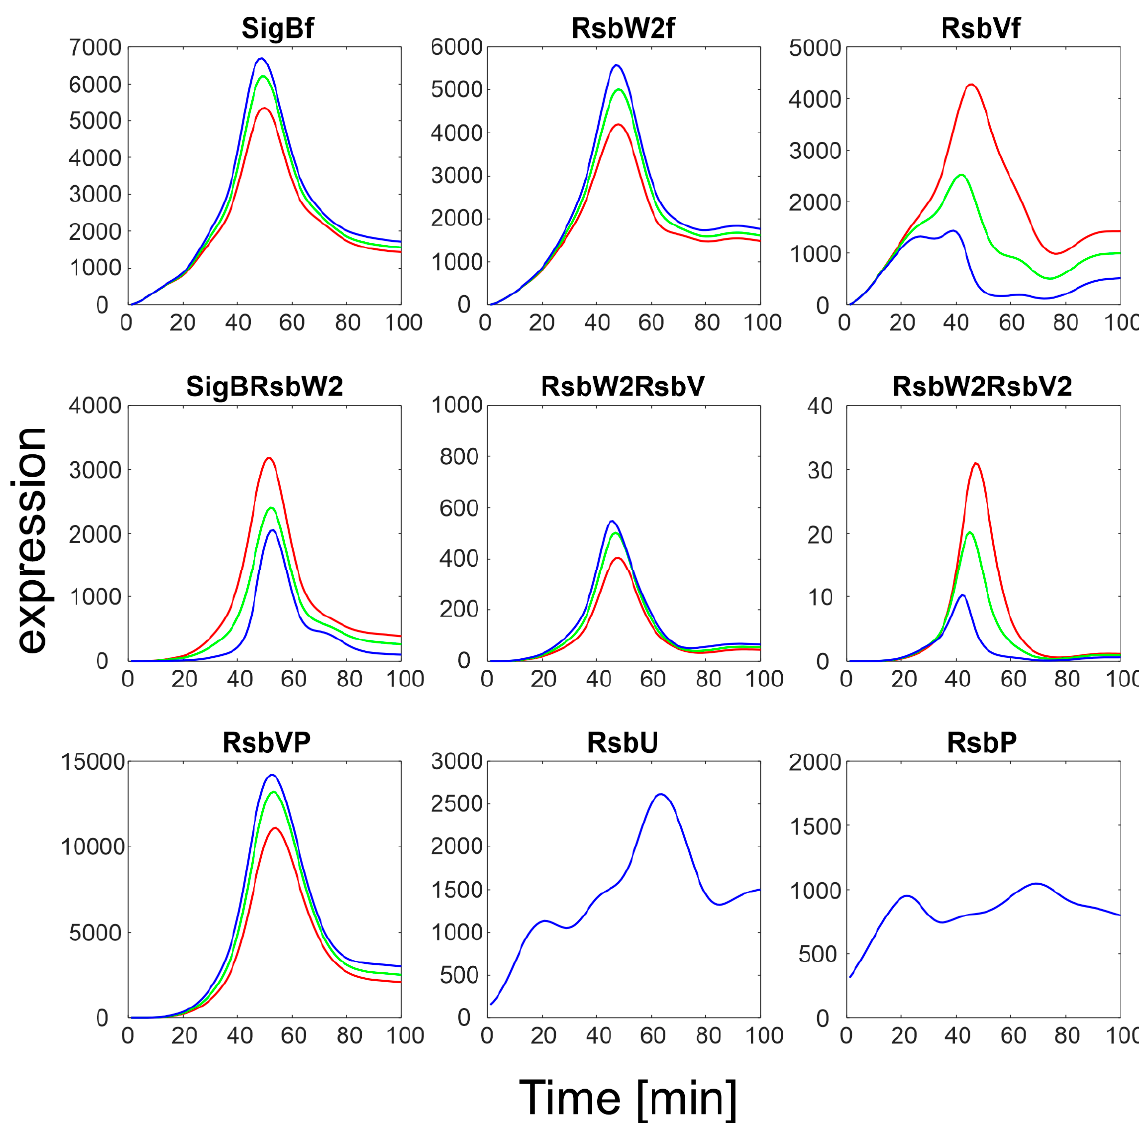
Figure 6. Simulation of influence of the ratio k 6 − /k 6+ controlling displacement of sigma factor by anti-anti-sigma factor. Red: original values as in Table 1, green: k 6 − /k 6+ = 100, blue: k 6 − /k 6+ = 1x10 5 .